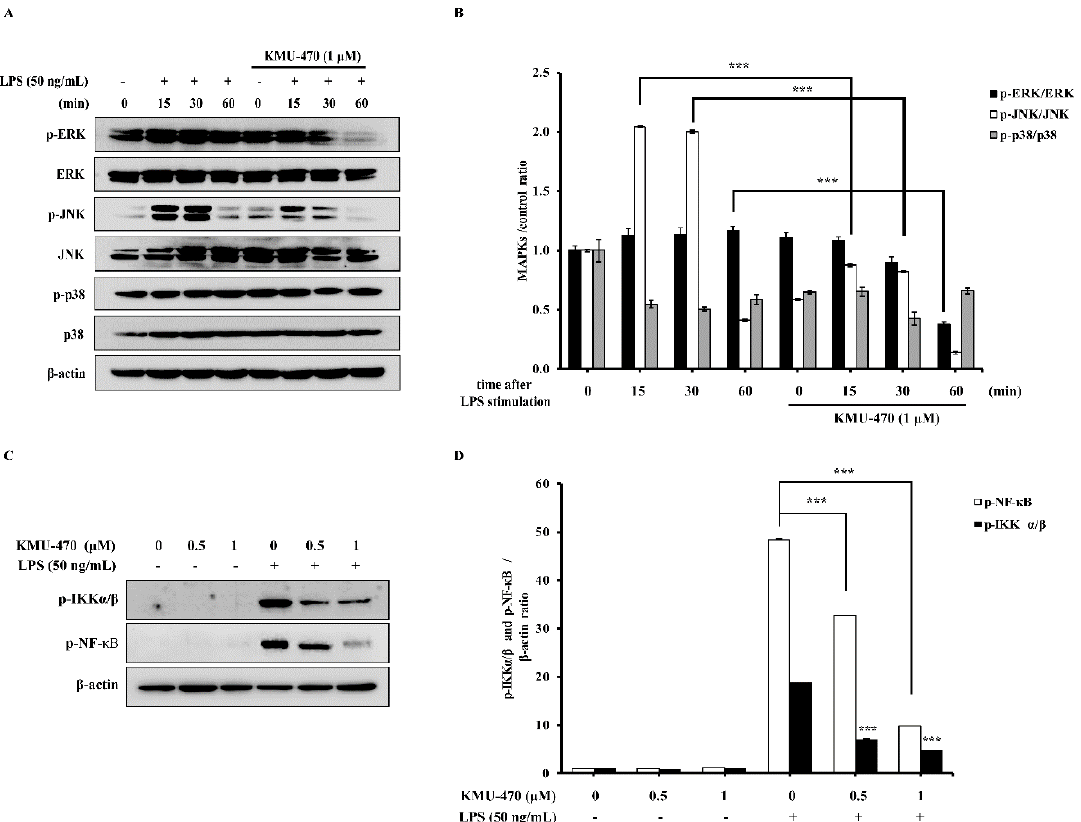
Figure 5. Effect of KMU-470 on LPS-induced phosphorylation of MAPKs/ IKKs/ NF-κB in RAW 264.7 Figure 5. E ff ect of KMU-470 on LPS-induced phosphorylation of MAPKs / IKKs / NF- κ B in RAW 264.7 cells. ( A ) Cells were pre-treated with 1μM of KMU-470 for 24 h and stimulated with LPS (50 ng/mL) cells. ( A ) Cells were pre-treated with 1 µ M of KMU-470 for 24 h and stimulated with LPS (50 ng / mL) at at the indicated times. ( C ) Cells were pre-treated with 0.5 and 1μM of KMU-470 for 30 min prior to the indicated times. ( C ) Cells were pre-treated with 0.5 and 1 µ M of KMU-470 for 30 min prior to LPS LPS treatment. Total proteins were isolated after 6 h exposure to LPS (50 ng/mL). The protein treatment. Total proteins were isolated after 6 h exposure to LPS (50 ng / mL). The protein expression expression level of MAPKs, p-IKKα/β, and p-NF-κB were assessed using Western blot analyses. ( B , D ) level of MAPKs, p-IKK α / β , and p-NF- κ B were assessed using Western blot analyses. ( B , D ) The relative The relative optical densities of MAPKs, p-IKKα/β, and p-NF-κB bands were analyzed by the Image- optical densities of MAPKs, p-IKK α / β , and p-NF- κ B bands were analyzed by the Image-J program. J program. *** p < 0.001. *** p < 0.001.